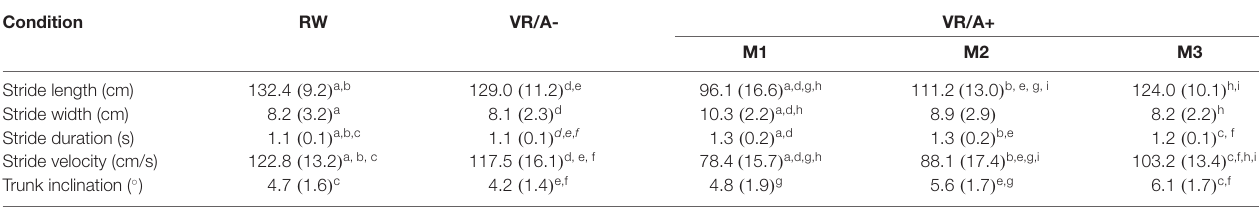
TABLE 2 | Kinematic measures.